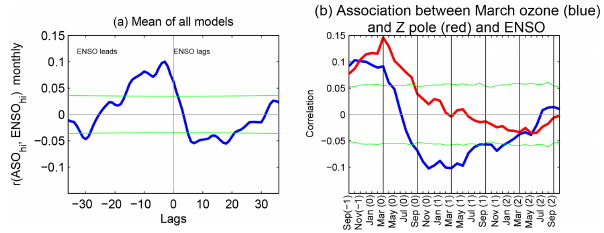
Figure 9. As in Fig. 8 but for the multimodel